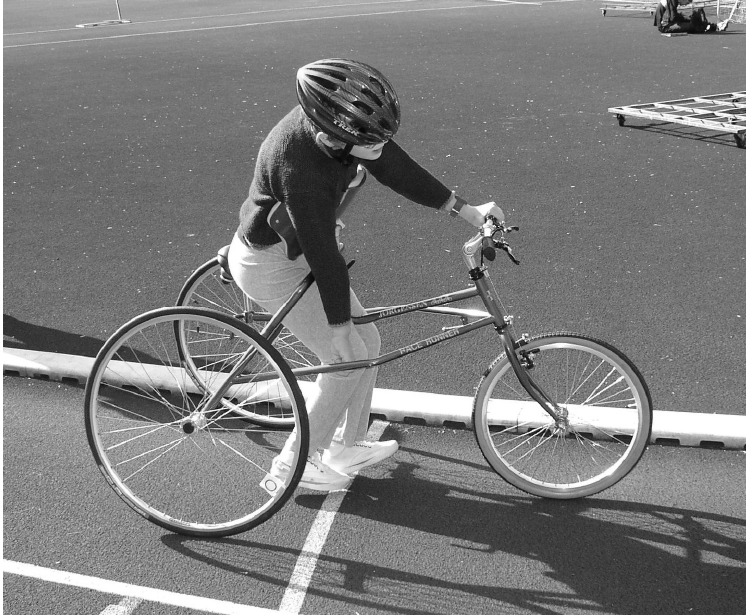
Figure 1. A Petra Race Runner in action on the athletic